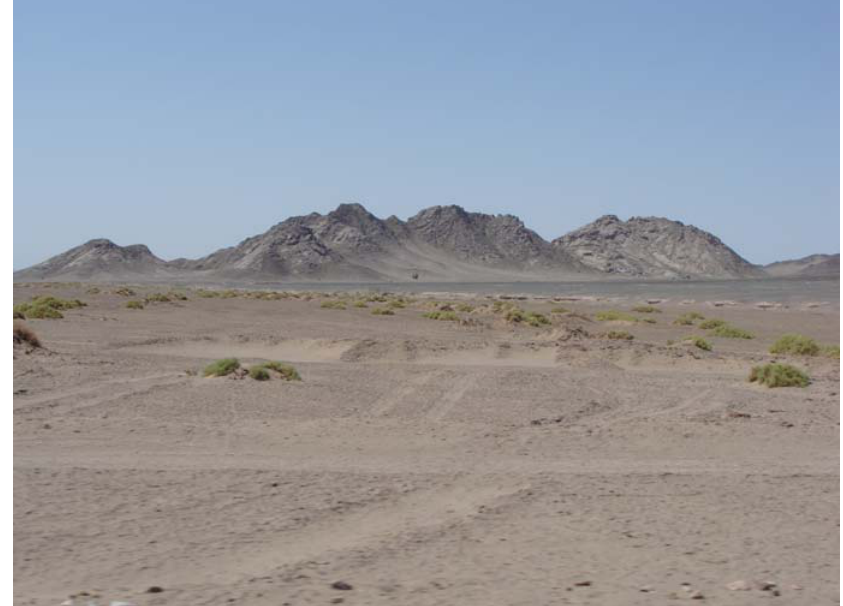
F IGURE 1. Habitat of Lacerta mostoufii in the Deh Salm village, 50 km Soutwest of Nehbandan, South Khorasan province, Iran.